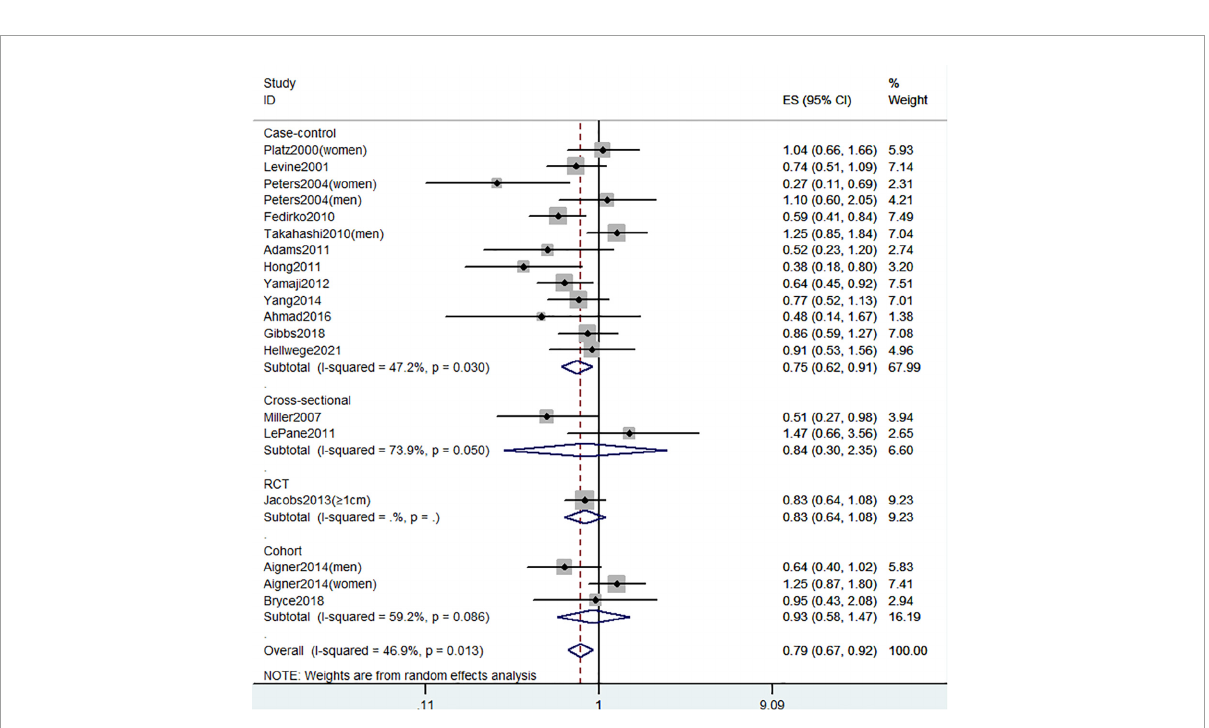
FIGURE8 Random-effects meta-analysis of studies that examined circulating 25(OH)D level and risk of CRC precursors incidence. ES, effect